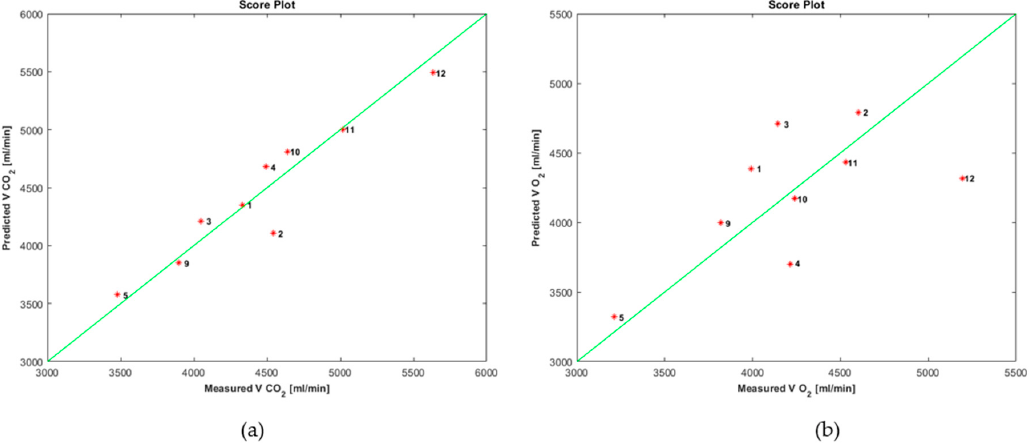
Figure 5. Score plot of: ( a ) VCO 2 ; ( b ) VO 2 using data from exhaled breath.